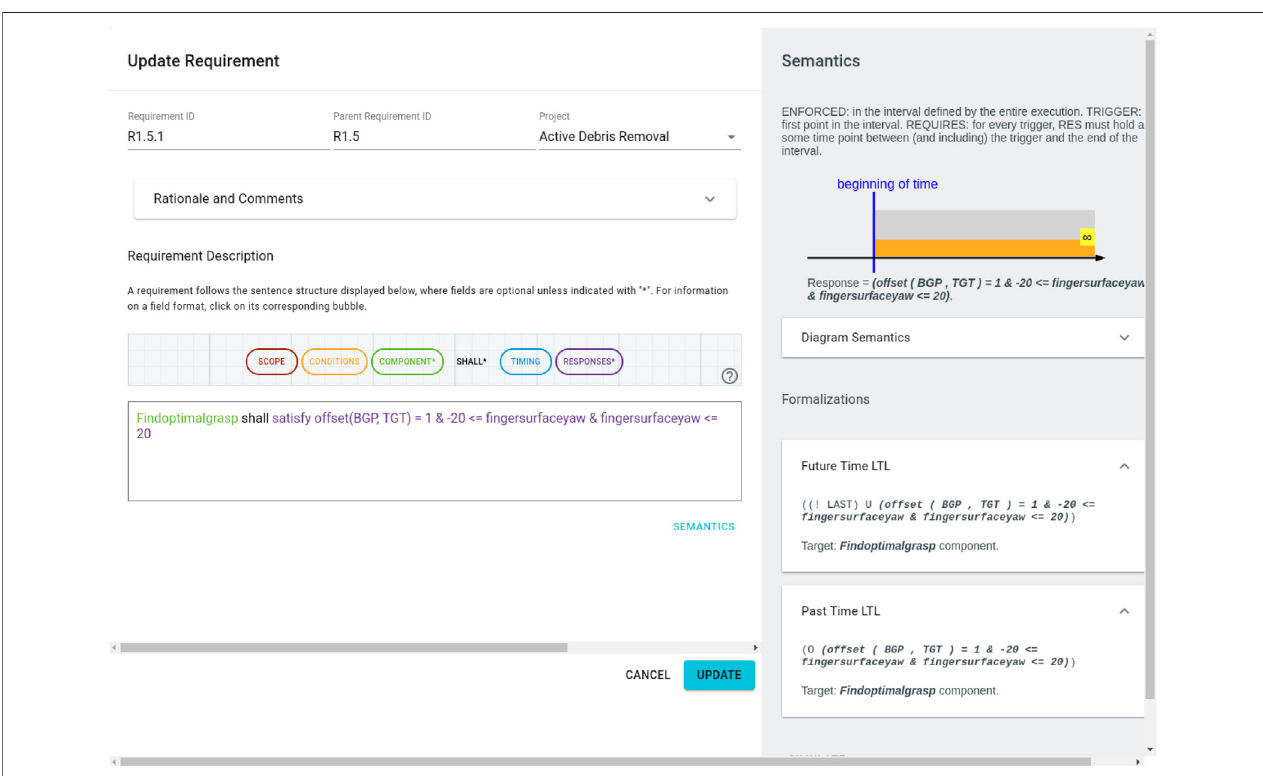
FIGURE2| ScreenshotfromFRETcorrespondingtoR1.5.2whichdescribeshowthebestgrasppose(BGP)ischosen.EachFRETrequirementisgivenanID(top left), there is an option to include Rationale and Comments which can be useful to promote traceability. Requirements are described in FRETISH with automatic syntax highlighting. Then, FRET generates both diagrammatic and LTL semantics (right hand side) corresponding to the requirment.